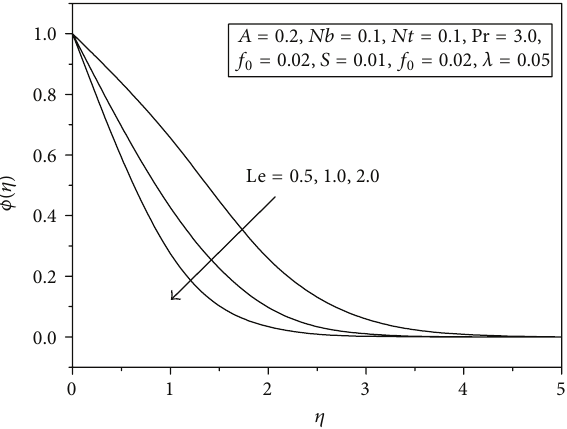
Figure 13: Concentration profile for different values of Le.